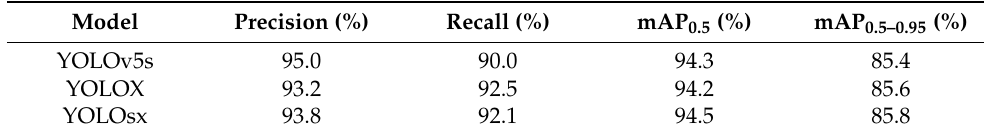
Table 4. Results of YOLOv5s, YOLOxs, and YOLOsxlc in posture